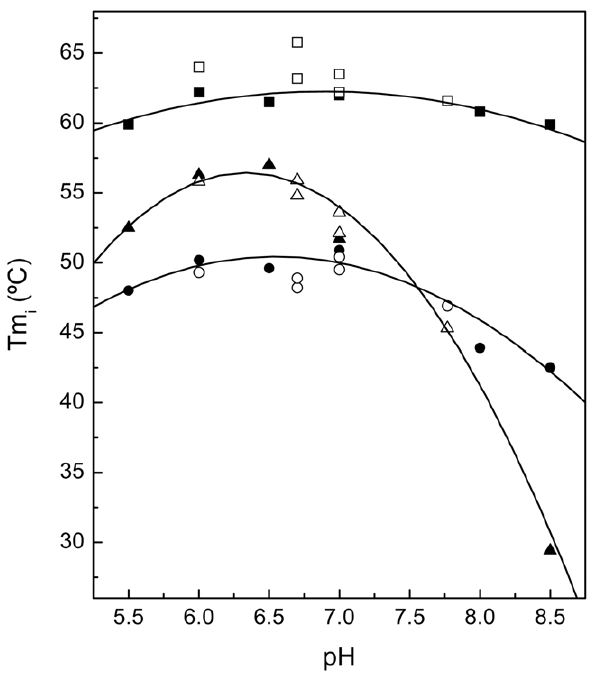
Figure 6. Dependence of T mi values of Cpl-7 transitions with pH. Solid and open symbols represent the estimates from CD and DSC denaturation profiles, respectively: Tm 1 , circles; Tm 2 , triangles; and Tm 3 , squares.